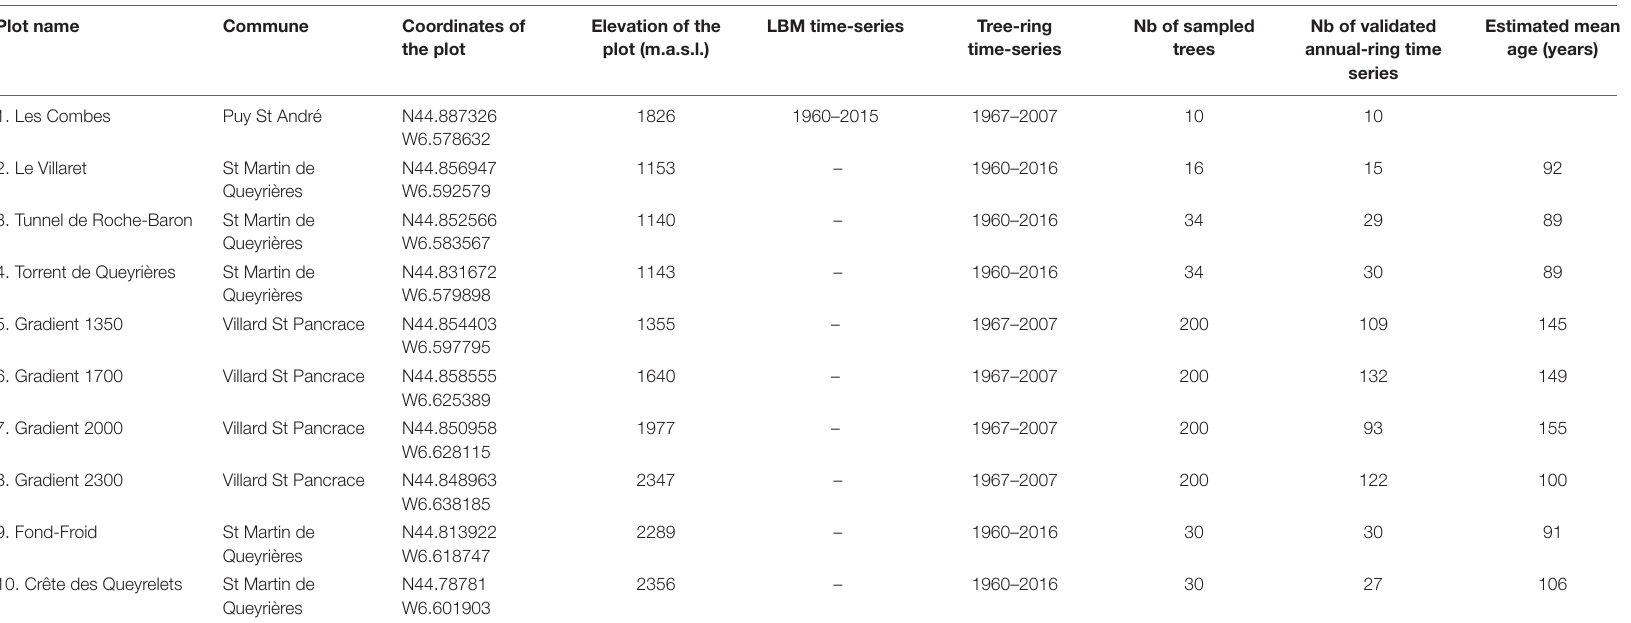
TABLE 1 | Description of study sites and direct and indirect LBM time-series. Plot